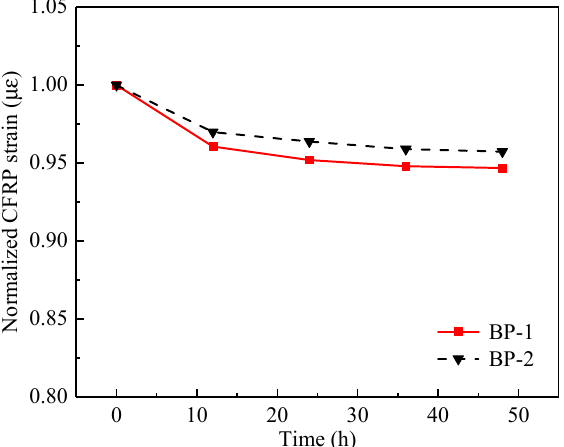
Figure 4. Variations of the normalized CFRP strain with time.